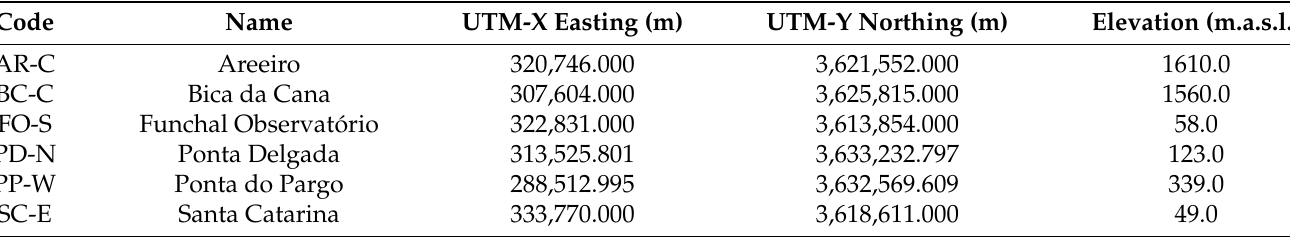
Table 1. The six rain gauges adopted in the study. Identification (code and name), coordinates WGS84 (UTM zone 28N), and elevation. In the code, the character after the hyphen indicates the location of the gauge, i.e., C for centre and S, N, W, and E for southern, northern, western, and eastern coastal areas,